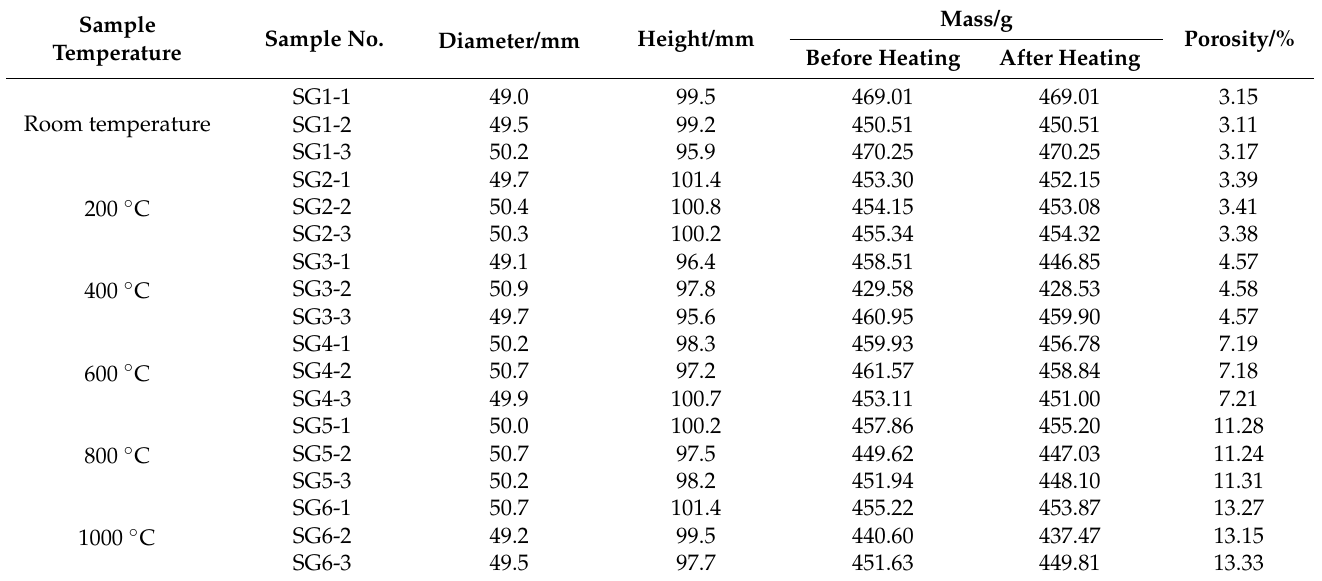
Table 2. Physical parameters of rock